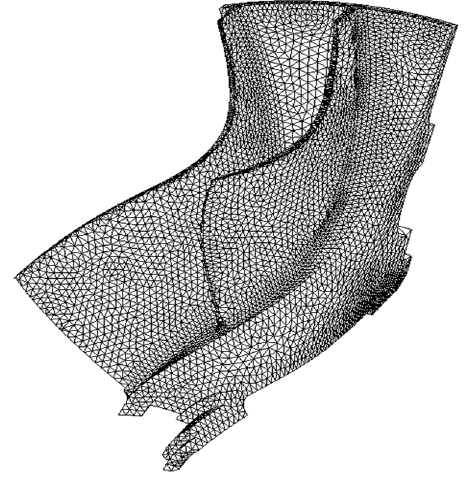
Figure 7. Finite element mesh of the impeller.